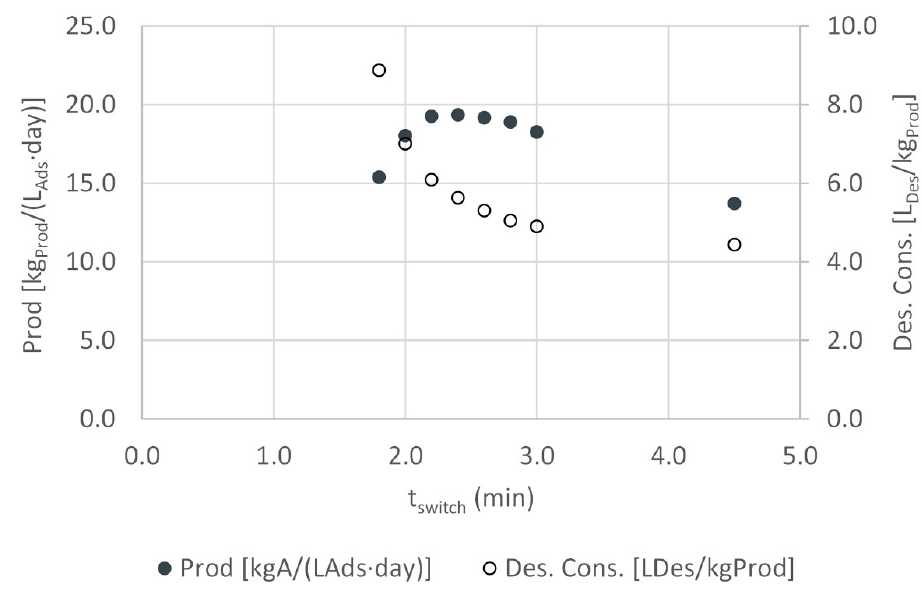
Figure 10. Sensitivity analysis regarding the influence of switching time on the productivity and the desorbent consumption, by setting a 20% safety factor for γ 1 and γ 4 .